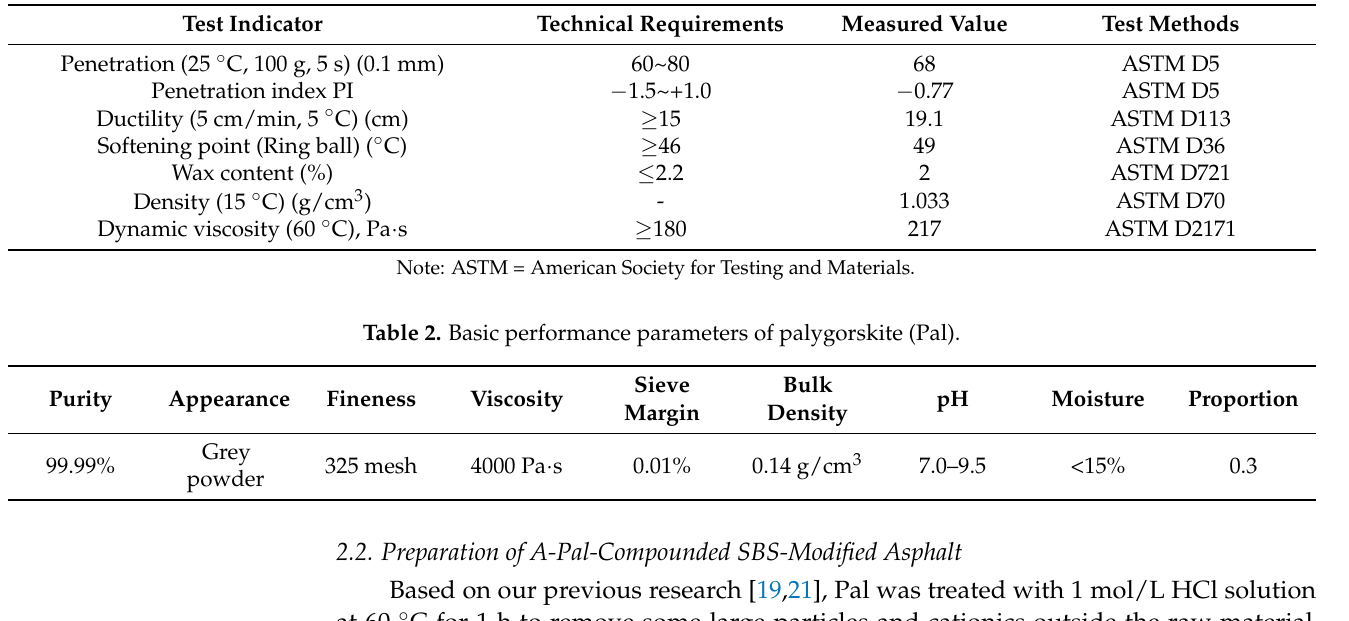
Table 1. Test results of the 70# asphalt (AH-70) asphalt matrix.